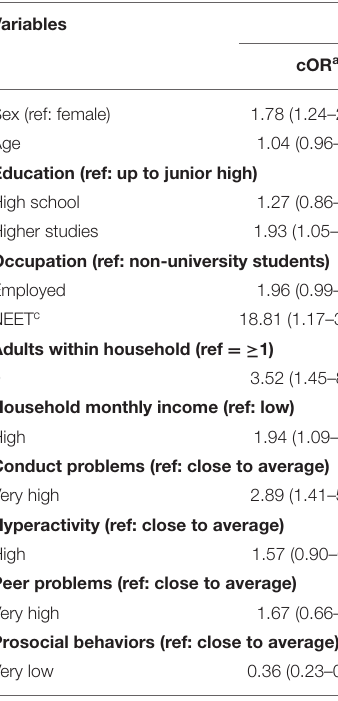
TABLE 5 | Regression analysis on alcohol and cigarette